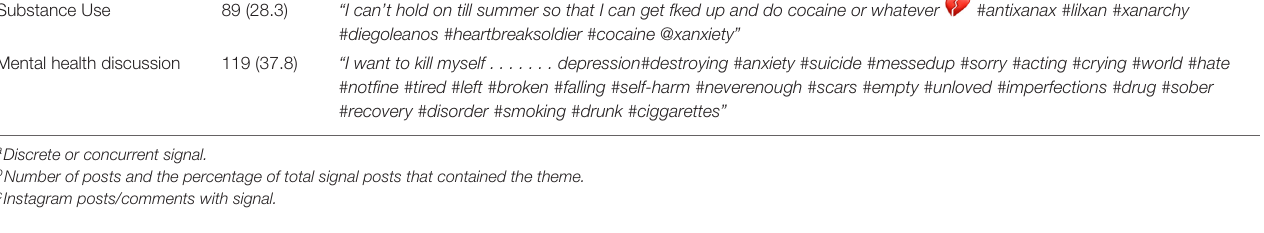
TABLE 2 | Number of posts with co-occurring discussions related to substance use behavior, suicide and/or self-harm, other mental health discussions (text of posts have been modified to de-identify from user, no user information reported). Theme a Posts b Example conversation c Suicide concurrent with substance use 52